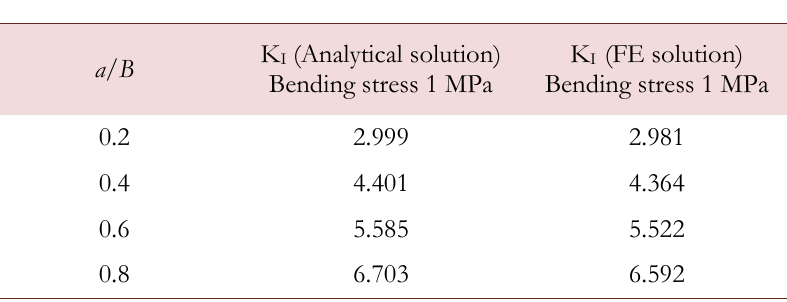
Table 3: Comparison of K I for analytical and numerical